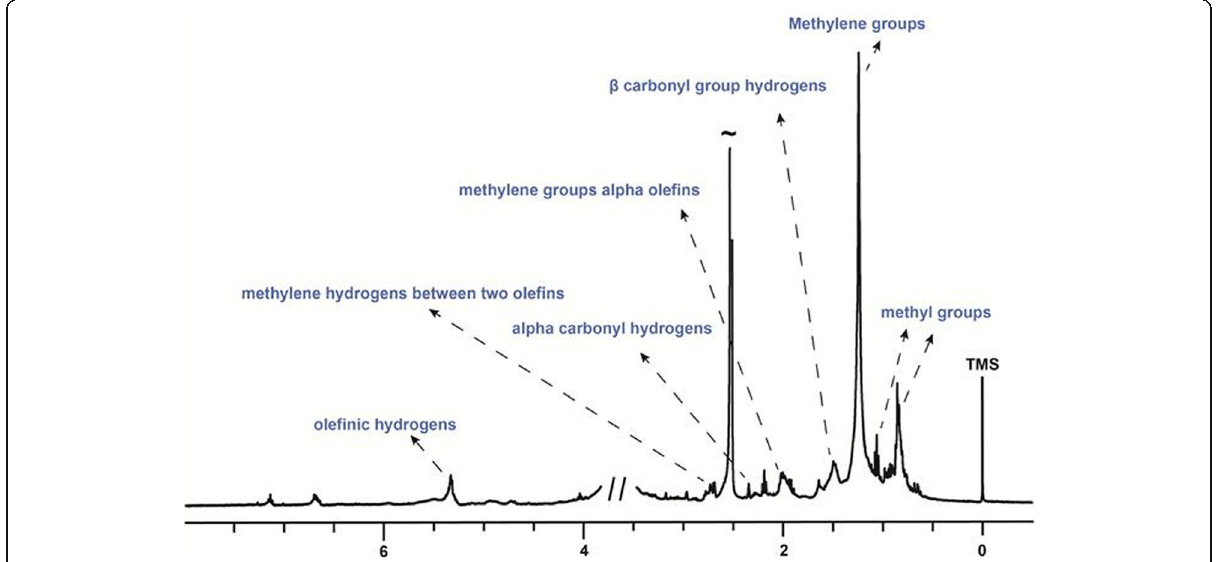
Fig. 2 Representative 1 H NMR spectrum of hexane extract of Spondias tuberosa